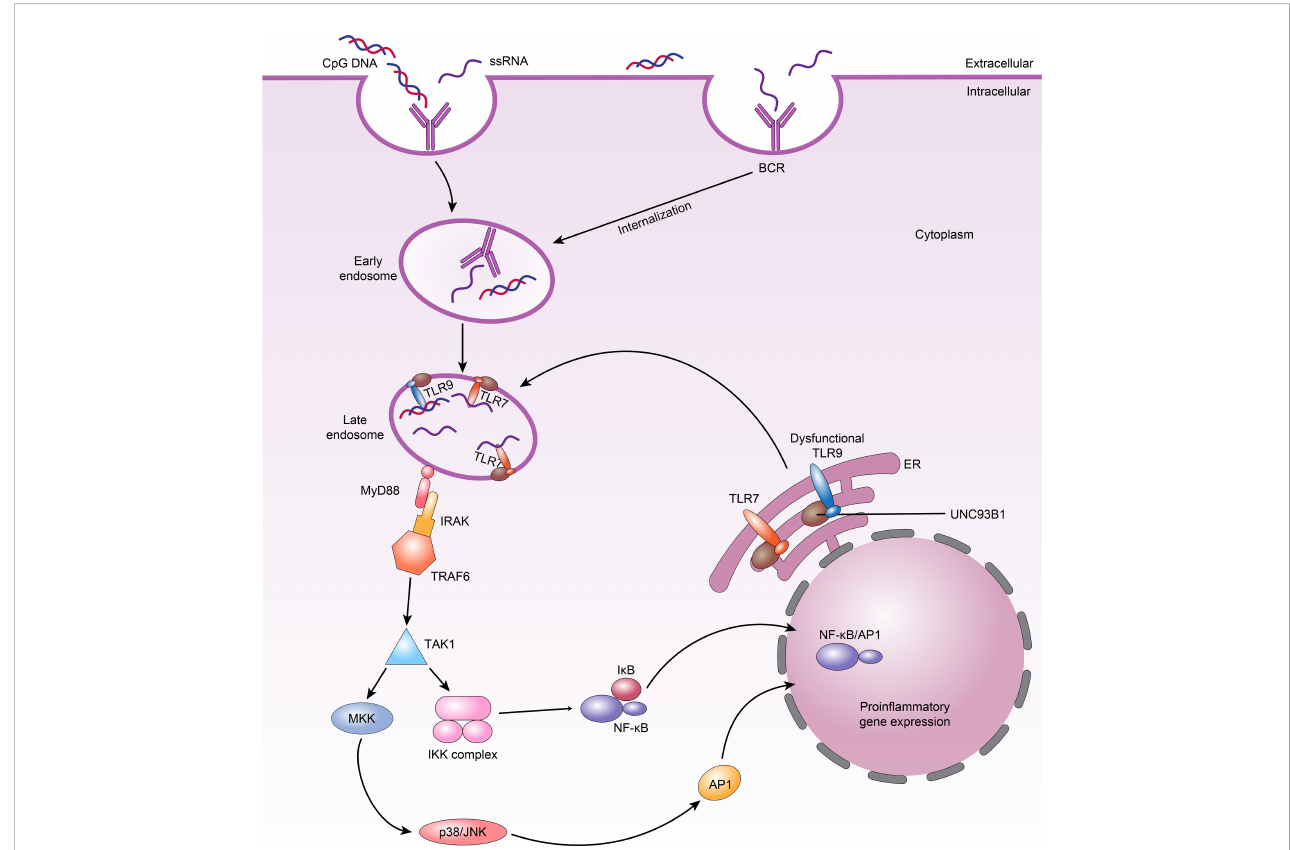
FIGURE 2 TLRs signalling in B cells and TLR7 and dysfunctional TLR9 compete for UNC93B1-dependent traf fi cking in SLE B cells. 1.When nucleic acid ligands are recognized by BCRs and internalized into B cells, they bind TLR7 or TLR9 in the late endosome; TLR7 or TLR9 then binds MyD88. MyD88 subsequently recruits the IRAK – TRAF6 complex, ultimately leading to activation of downstream NF- k B and AP1 signalling. 2.Dysfunctional TLR9 can lead to weakened competition of these TLRs for binding to UNC93B1 in endosomes, increasing TLR7 availability and resulting in higher TLR7 traf fi cking and responses, which manifest as autoimmune